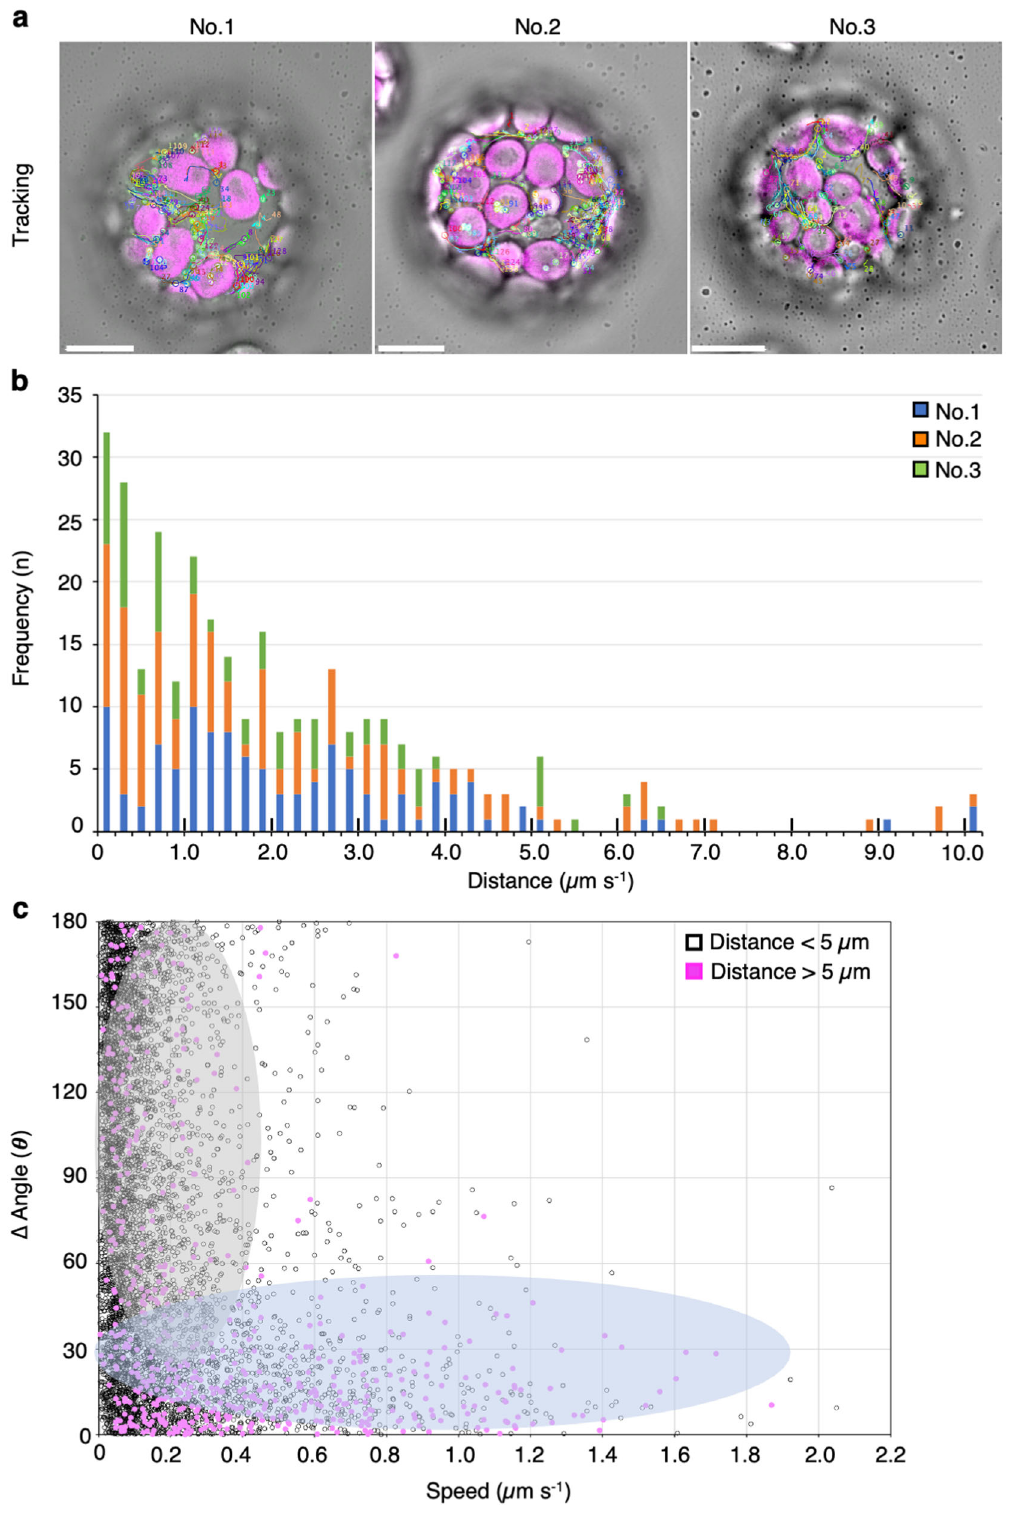
Fig. 2 Characterization of mitochondrial movements in leaf mesophyll protoplasts. a Trajectories of mitochondrial movements constructed from time- lapse analysis of images of three different protoplasts (No. 1 – 3) acquired for 30 s at 250-ms intervals. Scale bar; 10 µ m. b Distribution of the direct distance between the fi rst and last point of mitochondria in the trajectories of mitochondrial movement acquired from three independent protoplasts (protoplast No. 1, blue color; protoplast No. 2, orange; and protoplast No. 3, green). c Scatter plot of speed ( x -axis) and angle changes ( y -axis) of mitochondria at each time point acquired from the trajectories of mitochondrial movement, which are separated based on a distance shorter (open circles) or longer ( fi lled-magenta circles) than 5.0 µ m in b . The plots are separated into two regions highlighted in gray and pale